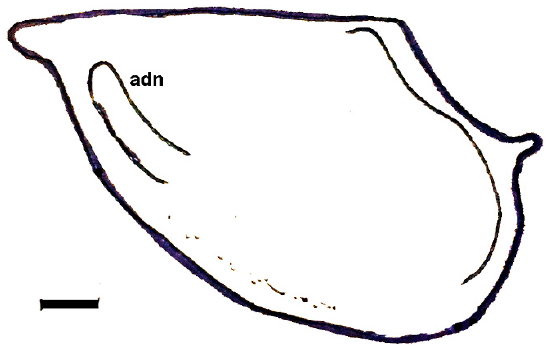
Figure 18. Jiucunella phaseloa . Anterior to left. Scale bar 200 microns. Abbreviation: adn , anterodorsal node. Image Credit: Mark McMenamin.